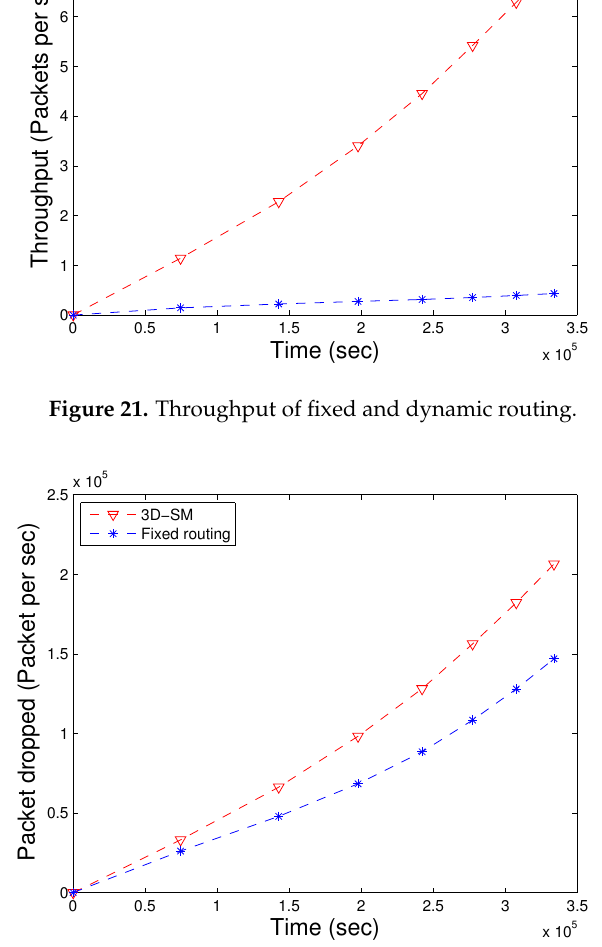
Figure 22. Packet drops of fixed and dynamic routing.